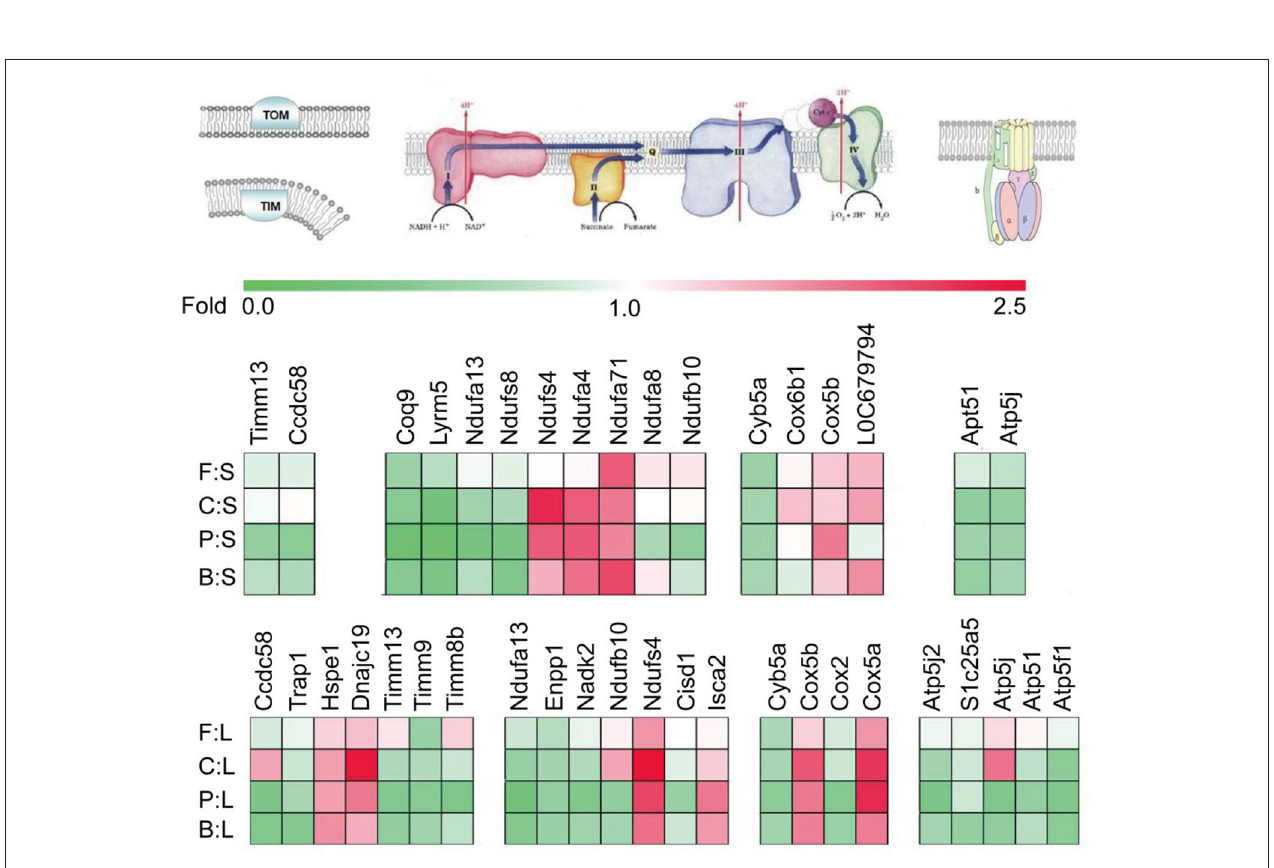
FIGURE 2 | Effect of dietary casein, soybean, and meat proteins on rat liver mitochondrial respiratory chain-related protein expression. The colors of squares indicate the direction of changes in proteins, with red for up-regulation and green for down-regulation. F:S, fish protein vs. soybean protein; C:S, chicken protein vs. soybean protein; P:S, pork protein vs. soybean protein; B:S, beef protein vs. soybean protein; F:L, fish protein vs. casein; C:L, chicken protein vs. casein; P:L, pork protein vs. casein; B:L, beef protein vs. casein.